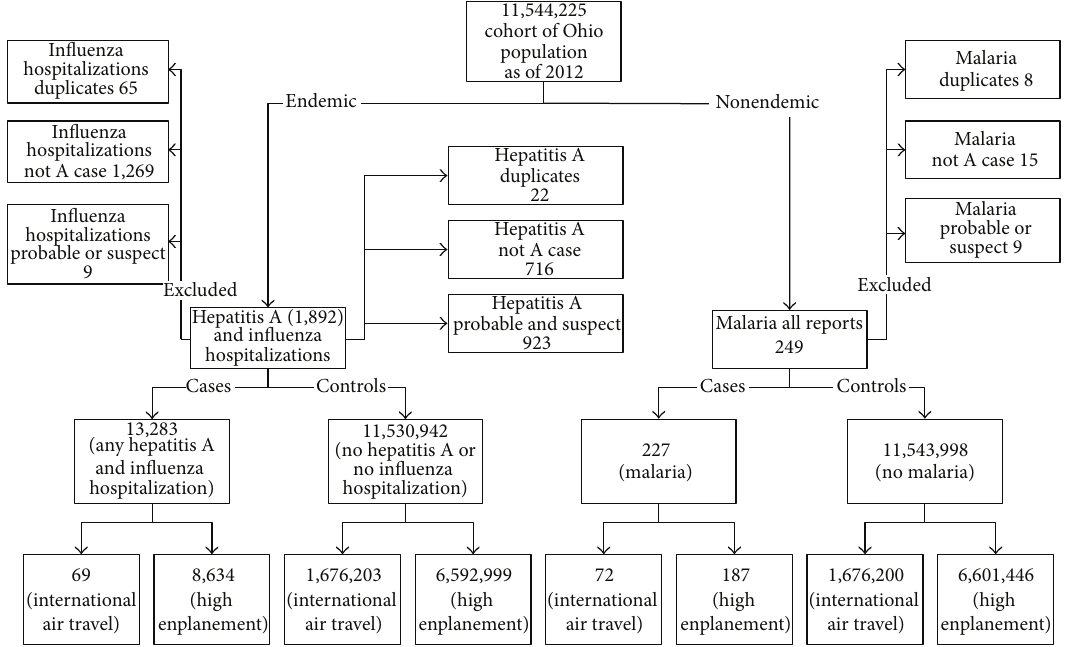
Figure 2: Assignment of cases and controls to exposure to international air travel (derived from total number of US passports issued) and high enplanement (amount of boarding